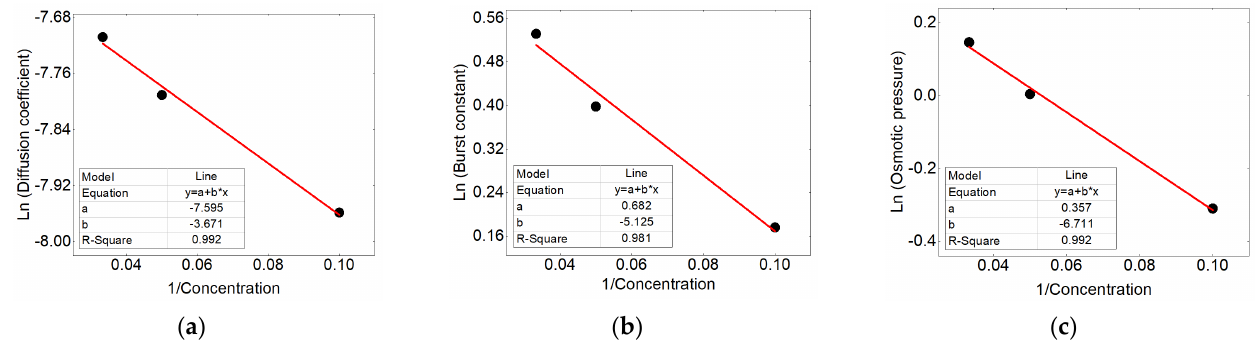
Figure 11. Correlation between ( a ) diffusion coefficient, ( b ) burst constant, ( c ) osmotic pressure in accordance to the concentration adapted to the Arrhenius equation.